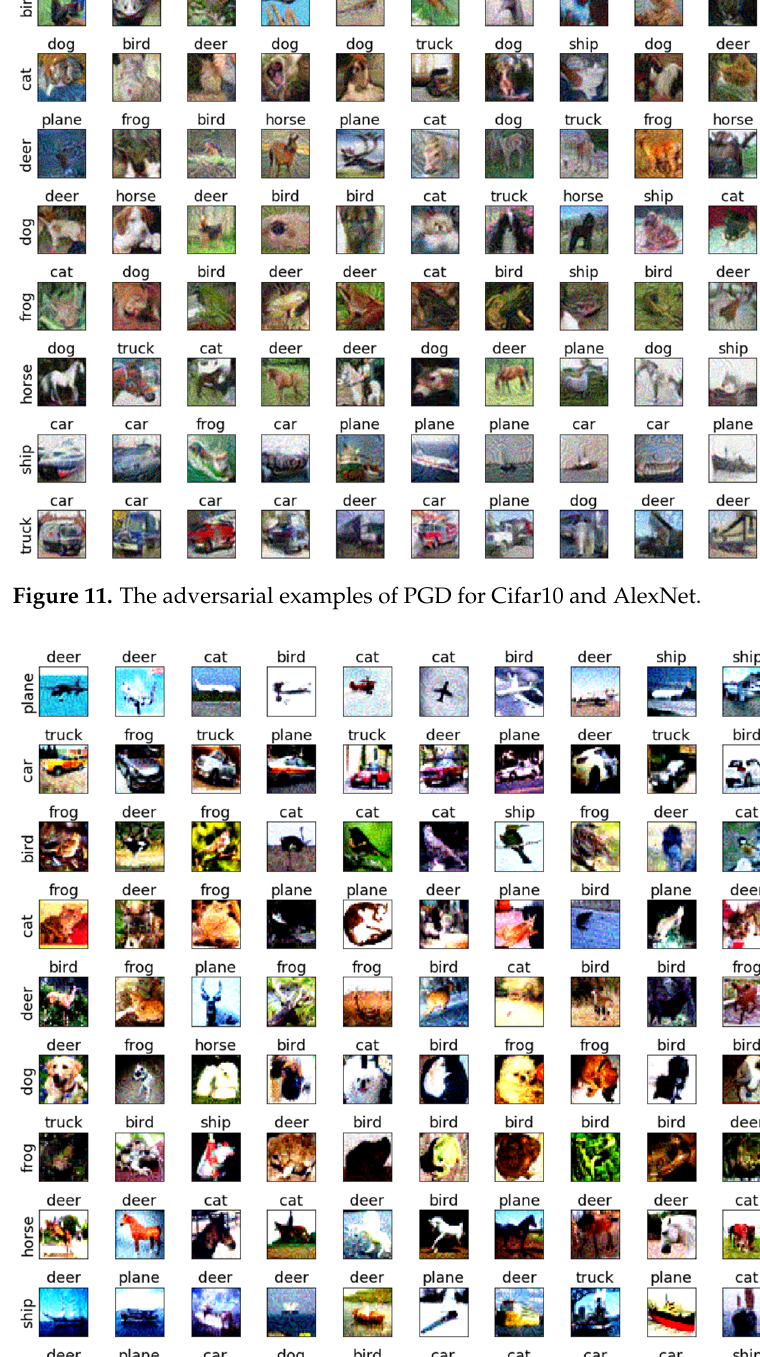
Figure 12. The adversarial examples of BMI-FGSM for Cifar10 and AlexNet.